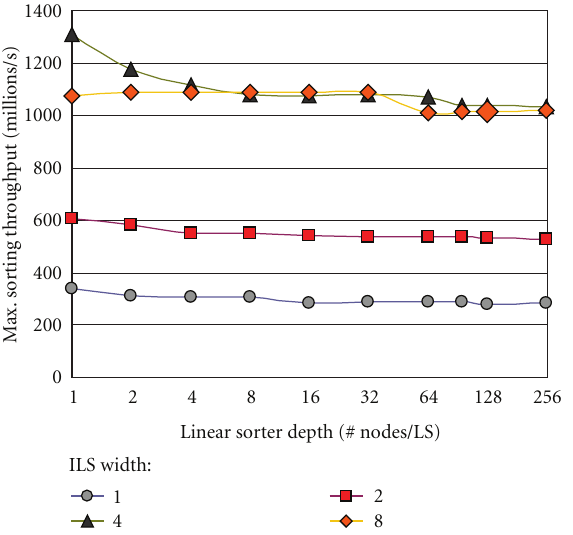
Figure 10: Maximum throughput for interleaved linear sorters.